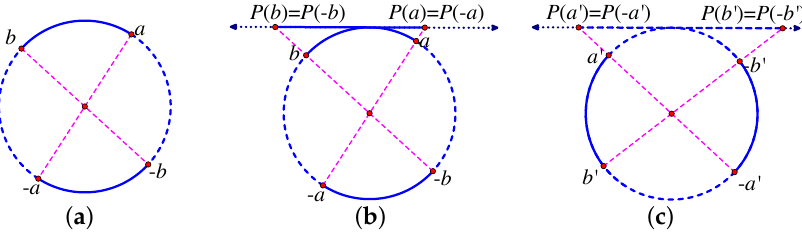
Figure 70. A pair of points on a sphere lie on a circle defined by the two points and the center of the sphere. The points and their antipodes end up as the same pair of points in the projection to the line. With their antipodal points a strut extends to two struts and two cables between the pairs ( a ). When projected from the center, the strut in ( a ) goes to a strut ( b ). After a rotation ( c ), it is the cable that appears in the